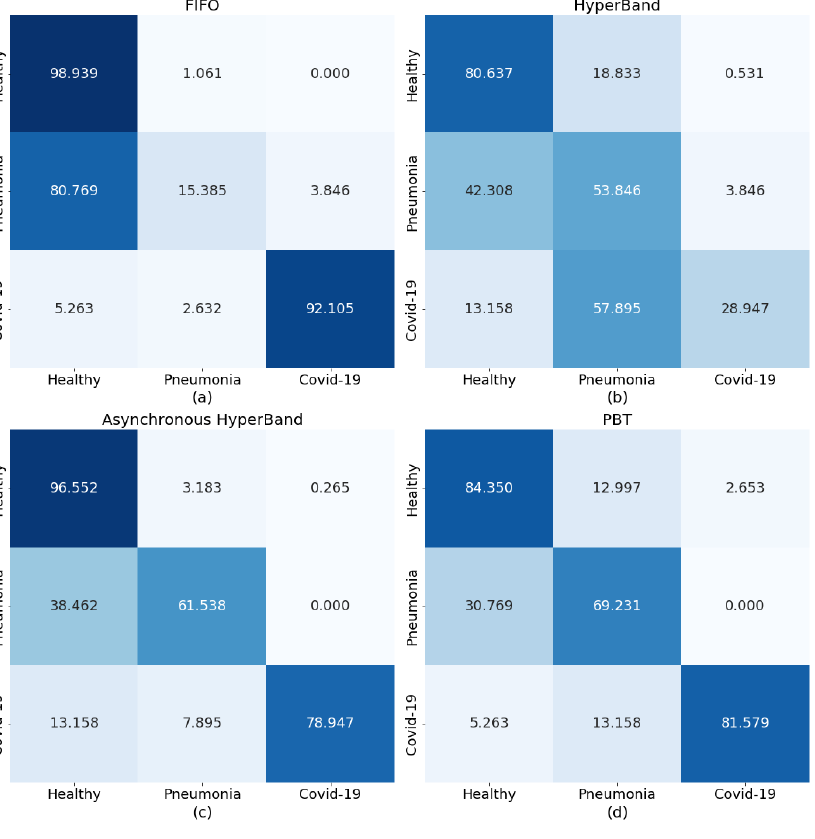
Figure 4. Prediction performance heatmaps for COVID-Net on the EHL dataset after re-training on the parameters chosen by ( a ) FIFO, ( b ) HyperBand, ( c ) Asynchronous HyperBand, and ( d )